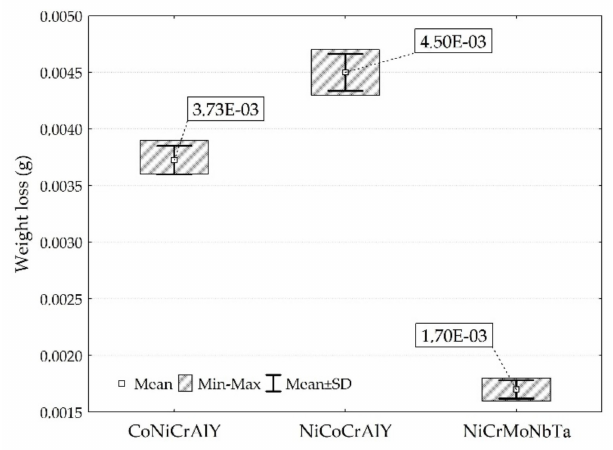
Figure 9. Mass losses of tested coatings.